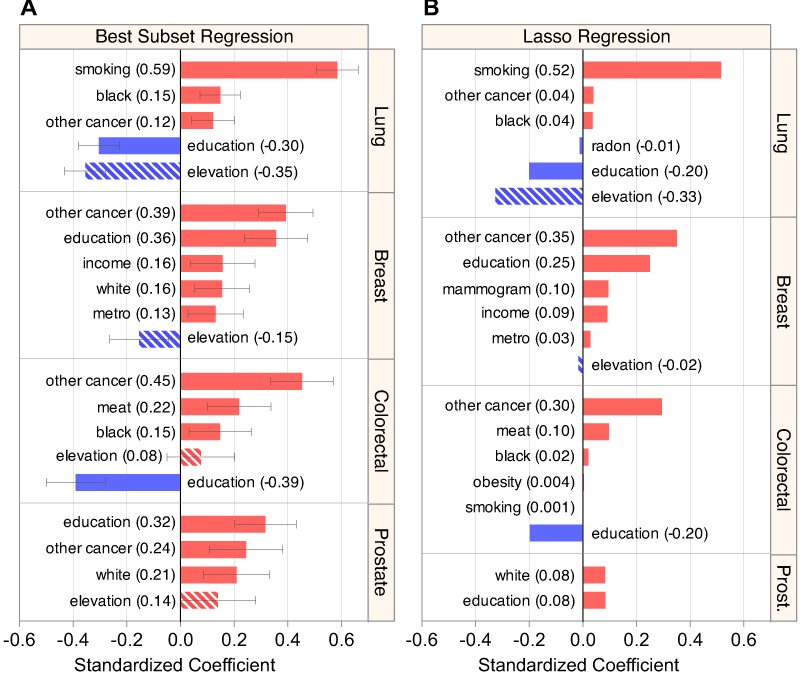
Regression models estimate elevation’s association while capturing known risk factors.(A) Summary of the predictors included in the optimal best subset model for each cancer (see Table S1 for more detail). (B) Summary of the models produced by lasso regression, displaying characteristic coefficient shrinkage. Both regression techniques produced similar sets of models that were sensible for lung, breast, and colorectal cancer. Elevation displayed a strong and consistent negative coefficient in lung cancer models.